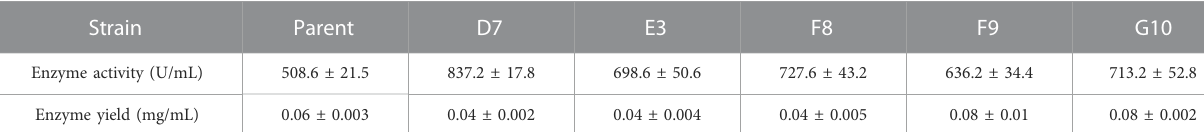
TABLE 2 The Enzyme activity and yield of parent and mutants expressed in P. pastoris Strain